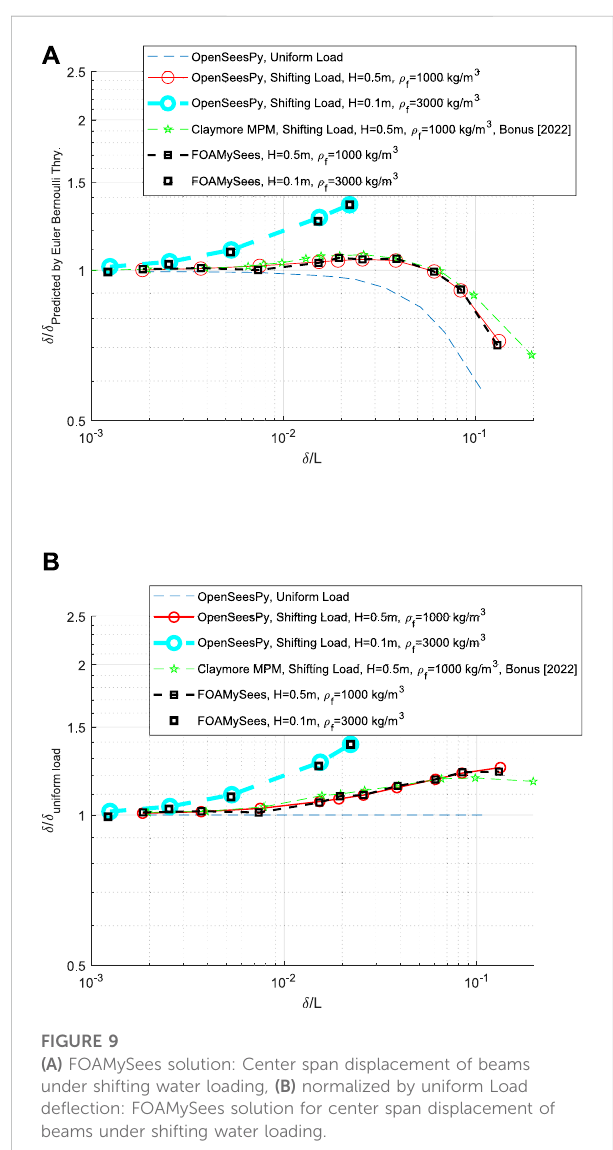
FIGURE 9 (A) FOAMySees solution: Center span displacement of beams under shifting water loading, (B) normalized by uniform Load de fl ection: FOAMySees solution for center span displacement of beams under shifting water